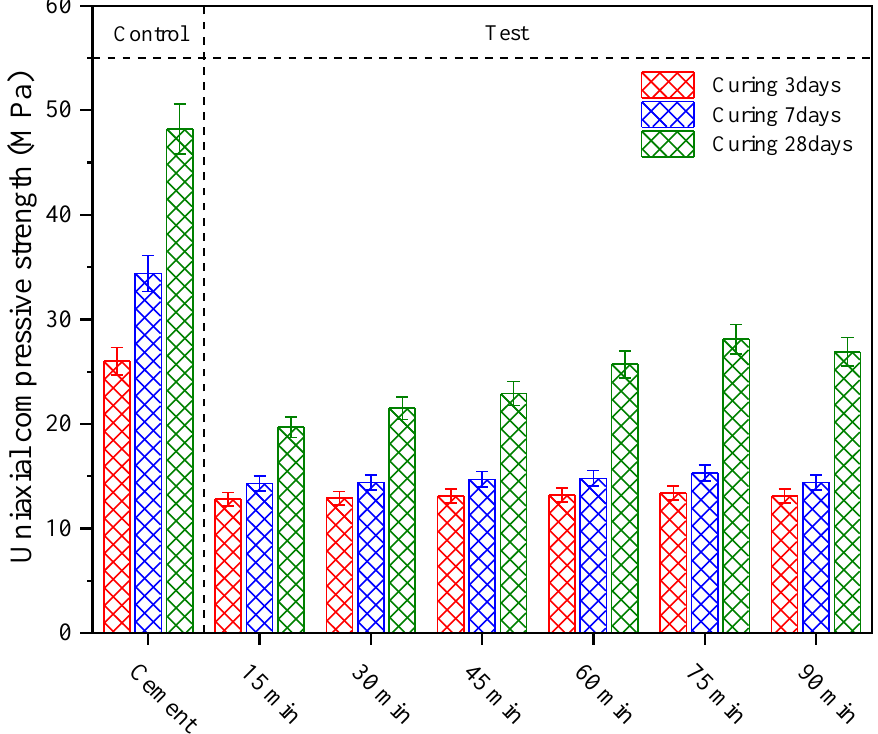
Figure 11. Uniaxial compressive strength test results of coal gasification slag-cement mortar at different grinding time.